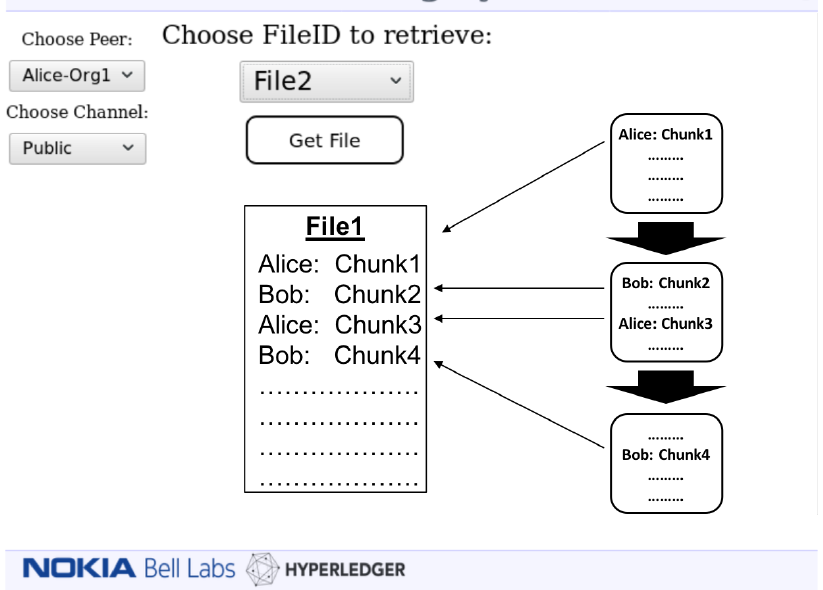
Figure 6. A screenshot taken from our proof-of-concept (POC) GUI demonstrating retrieval of a log file from the blockchain, where transactions stored in different blocks come together to create a single logical